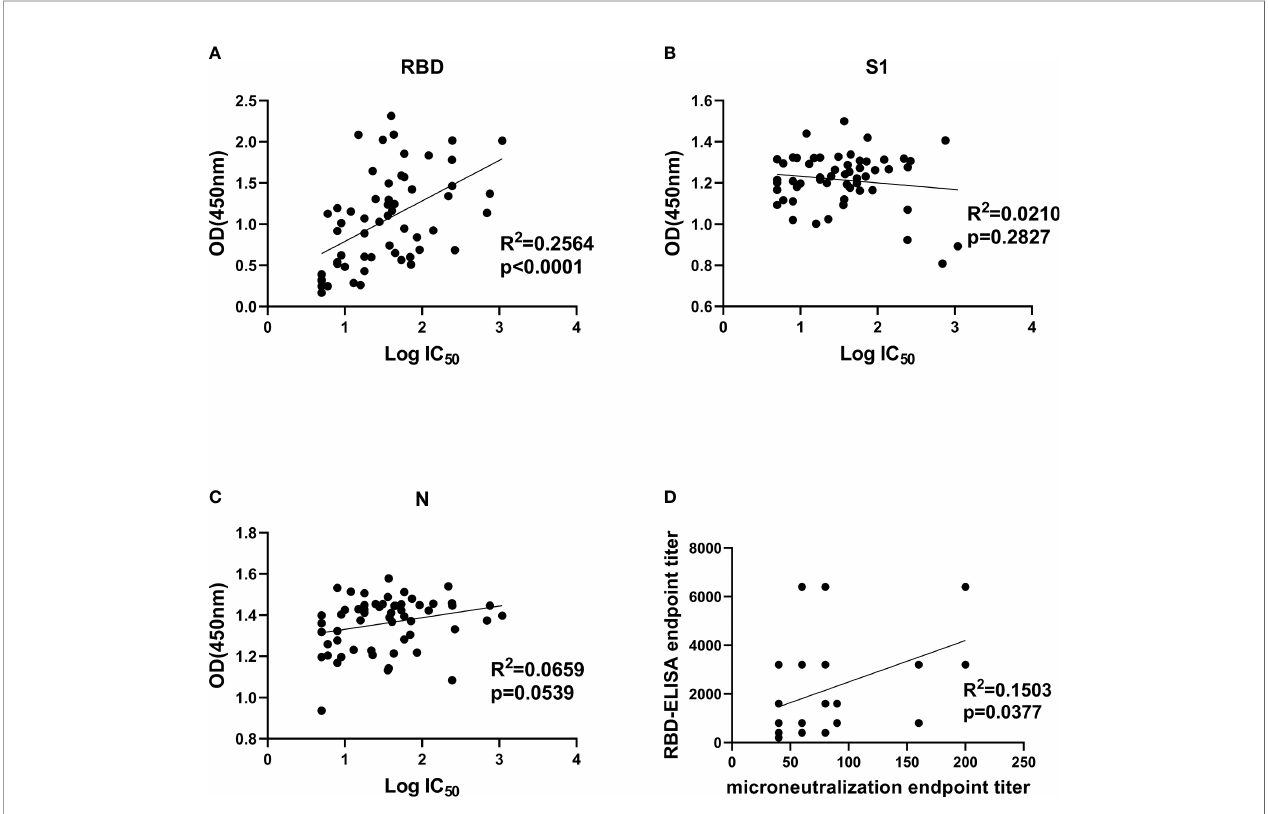
FIGURE 4 | Correlation analysis between IgG antibody levels and neutralization antibody titers. (A – C) , Correlation analysis between neutralizing titers and RBD-, S1-, and N-speci fi c IgG levels, respectively. Convalescent plasma collected from 57 COVID-19-recovered patients was used for SARS-CoV-2 pseudotype neutralization assay to test IC 50 and indirect ELISA to test OD450 values at a fi xed dilution (1:100). (D) , correlation analysis between authentic SARS-CoV-2 neutralizing antibody titers and anti-RBD IgG levels in convalescent plasma. Statistics analysis was performed by using Graphpad prism 8.4 software. IC 50 , half-maximum inhibitory concentration.